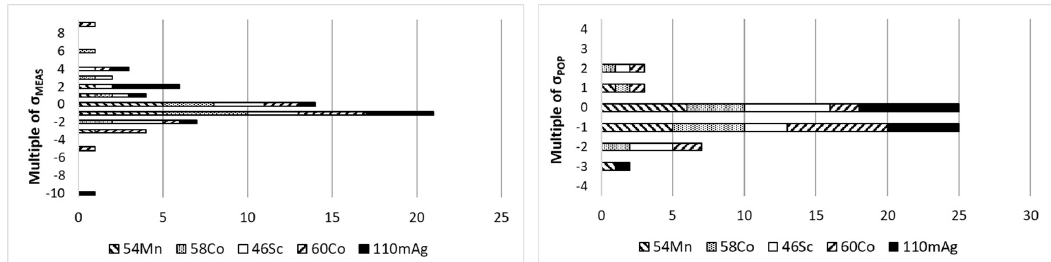
Fig. 6 Distributions of discrepancies from mean relative to measurement uncertainties, σ meas (on the left) and relative to standard deviation, σ pop (on the